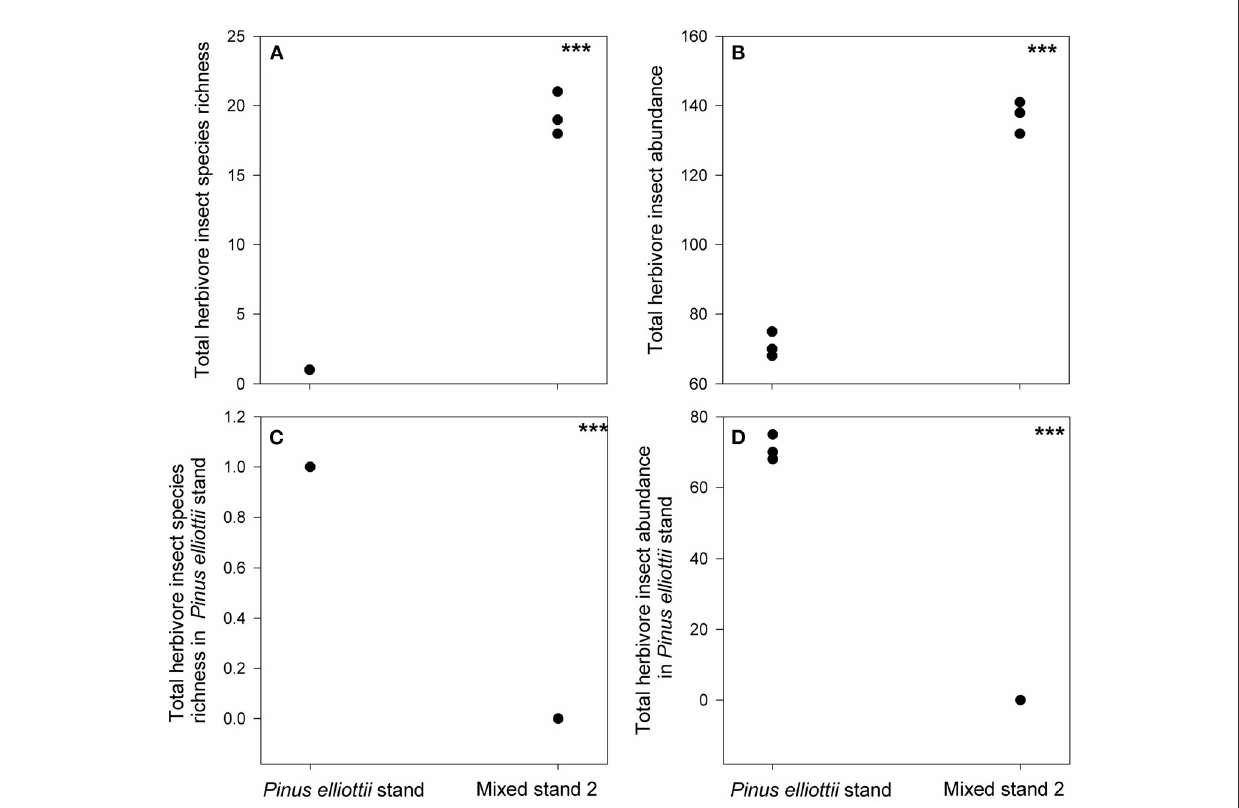
FIGURE5 Differences in total herbivore insect species richness (A) , total herbivore insect abundance (B) , total species richness of herbivore insects found in Pinus elliottii stand (C) and their abundance (D) between mixed stand 2 and Pinus elliottii stand. ***indicates p < 0.05, results from our generalized linear mixed effect model with Poisson